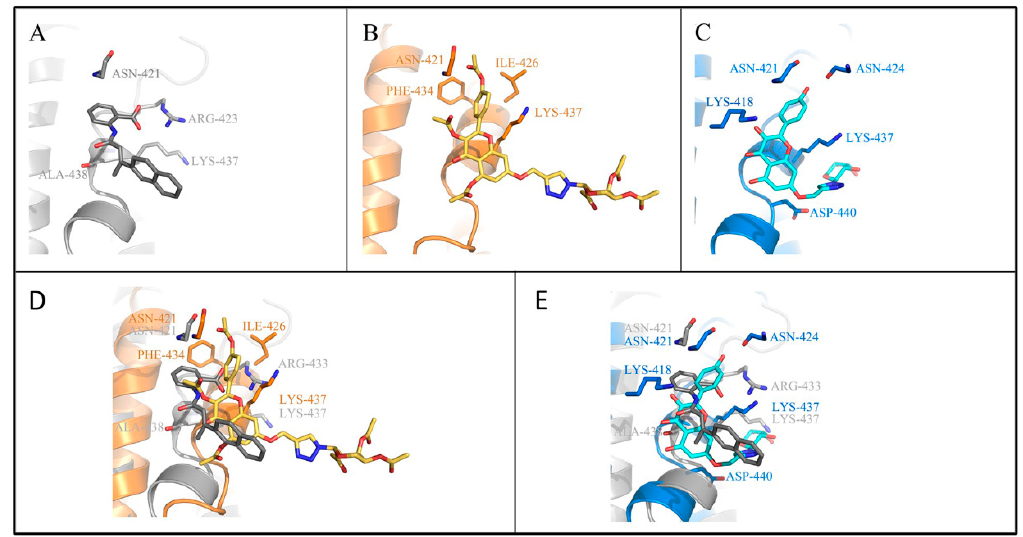
Figure 7 . Molecules interact with amino acids in the binding site. Docking of compounds BIBR1532 ( A ), 5c ( B ) and 6c ( C ) to the active site of telomerase. Superimposing of BIBR1532 (gray) and compound 5c (gold) ( D ) and 6c (blue) ( E ) in the active site of telomerase.